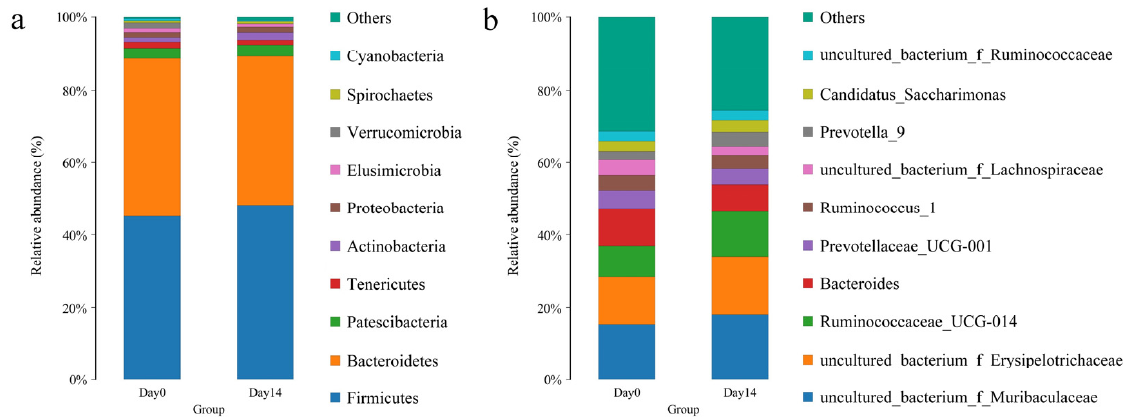
Figure 1. The ACE indexes ( left ) and Simpson indexes ( right ) of two groups, indicating the richness and diversity change after administration.